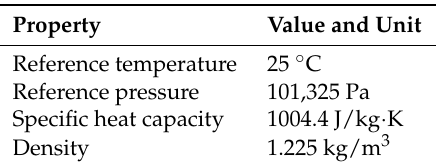
Table 2. Air materials properties in CFD